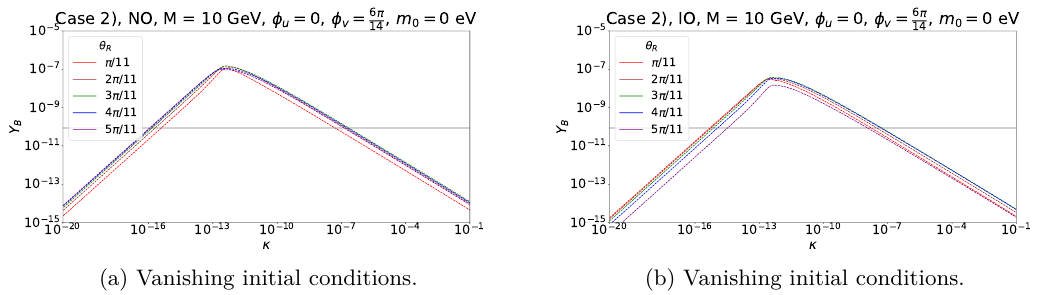
(b) Vanishing initial conditions. Figure 30 . Case 2) Y B as function of the splitting κ for a Majorana mass M = 10 GeV. Light